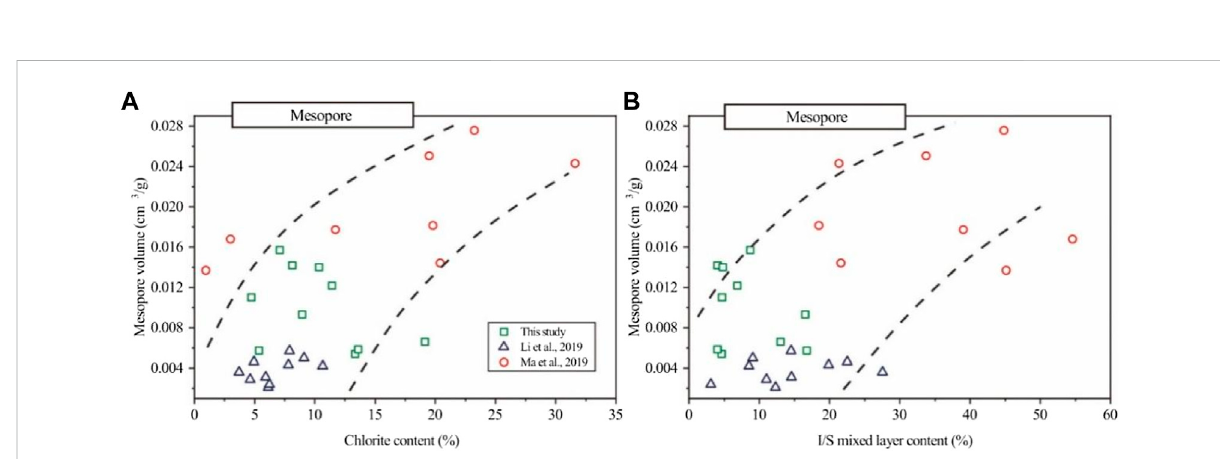
FIGURE 10 Correlation between clay minerals and mesopore volume in different marine-continental transitional shales. (A) Relationship between chlorite content and mesopore volume; (B) Relationship between I/S mixed layer content and mesopore